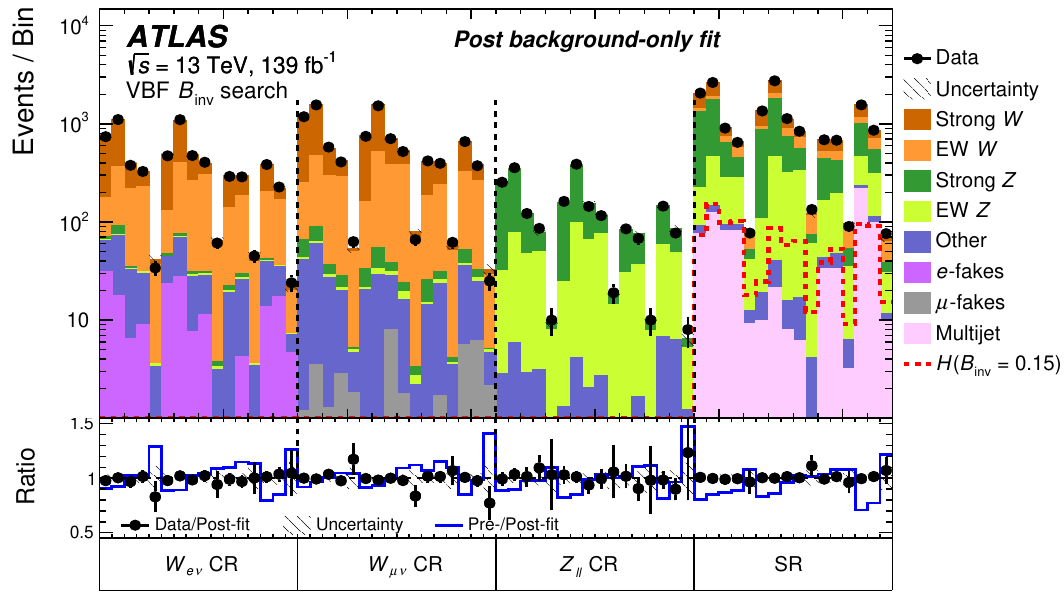
Figure 11. Post-fit results of all SR and CR bins with µ set to zero. Minor contributions from t ¯ t , V V , V V V , and VBF H with H → τ + τ − or H → W ∗ W are combined and labelled ‘other’. The signal (dashed, red line) is scaled to a branching ratio of 15% for Higgs boson decays into invisible particles. The 16 bins in the SR and each of the three CRs are defined in figure 2. The fake-lepton and pile-up CRs, which contain an additional 41 bins that also enter the likelihood fit, are not shown, as this improves the readability. The ratio of the observed yields to the prediction of the model post-fit is shown by the points in the bottom plot and the relative change of the prediction with respect to the pre-fit yields is shown by the blue